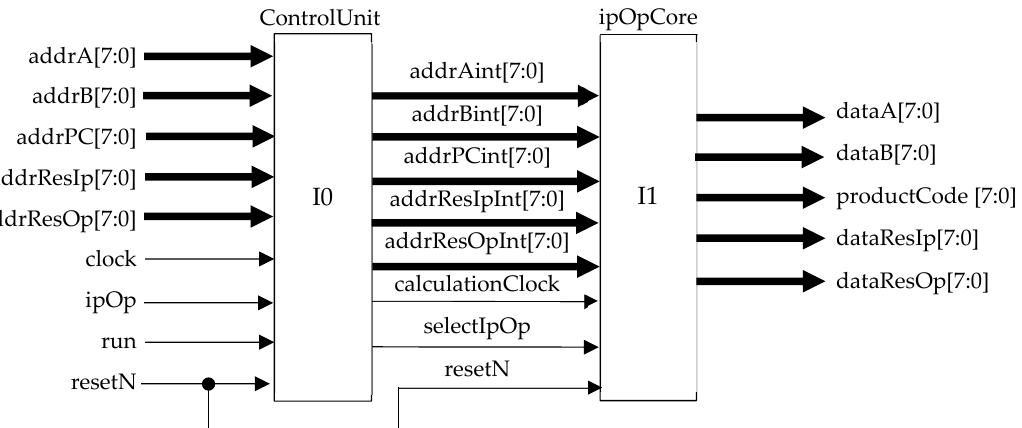
Figure 6. Simplified system block diagram.